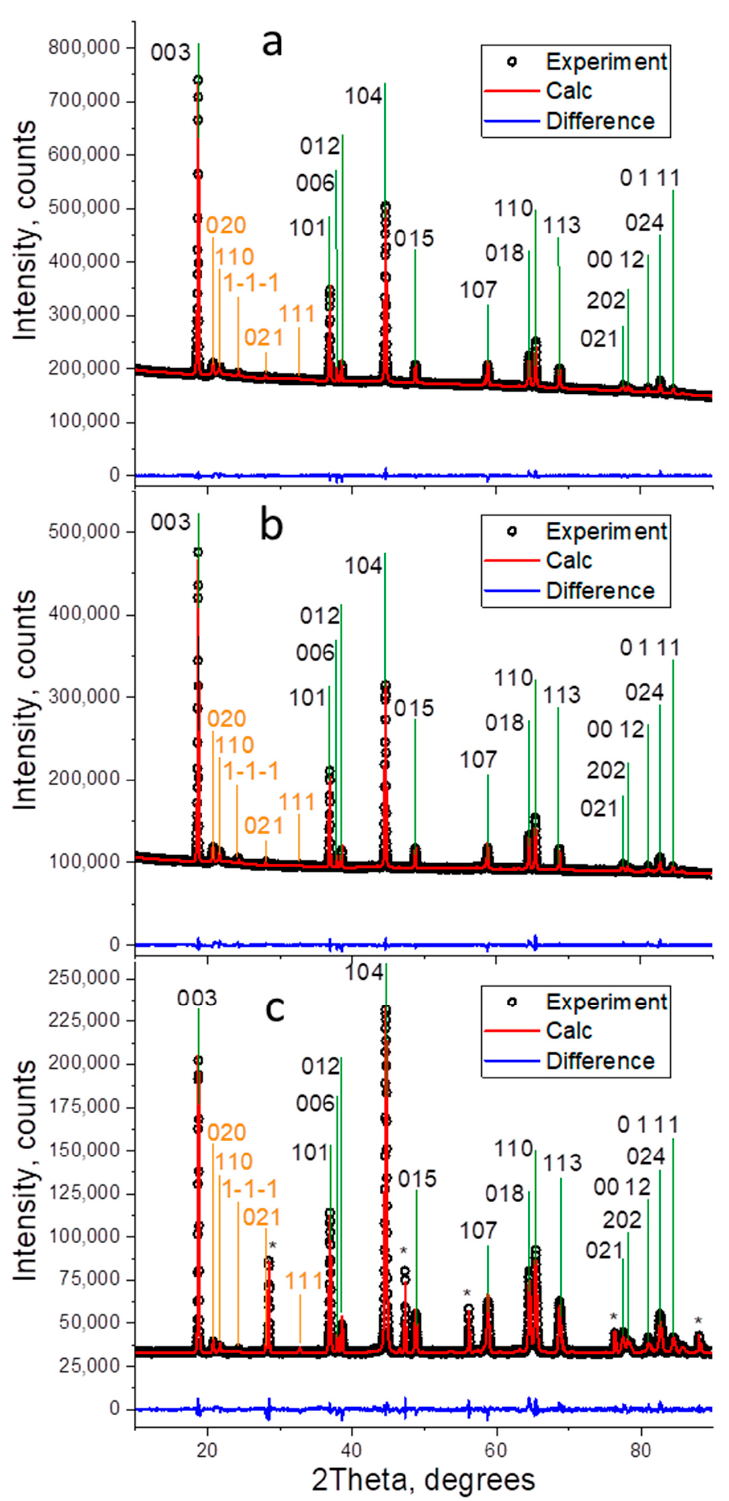
Figure 3. Refined powder X-ray diffraction patterns for materials prepared: ( a ) LR; ( b ) LR-Mg; and ( c ) LR-Mg(st). Diffraction measurements of LR and LR-Mg were carried out with a Ge monochromator; the diffraction pattern of LR-Mg(st) oxide was measured without monochromator using a Si standard reference; the Si lines are designated by asterisks.